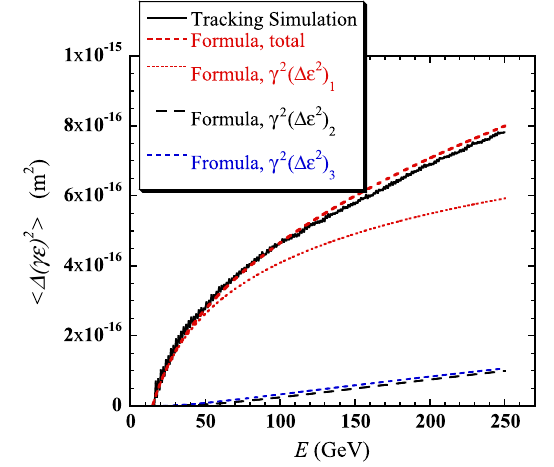
FIG. 2. Average growth of square of normalized emittance [ hð (cid:4)(cid:3) Þ 2 i ] with BPM offset error 50 (cid:10) m (rms) after one to one correction, as a function of beam energy along the ILC main linac. Results of tracking simulation and the analytic formula. , ð (cid:2) (cid:3) 2 Þ , and ð (cid:2) (cid:3) 2 Þ are also shown. Contributions of ð (cid:2) (cid:3) 2 Þ 1 2 3